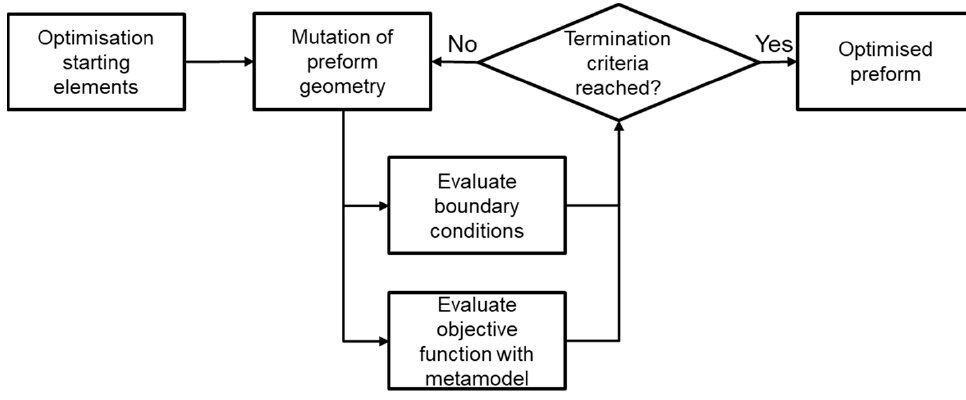
Figure 6. Flow chart of the optimisation procedure.